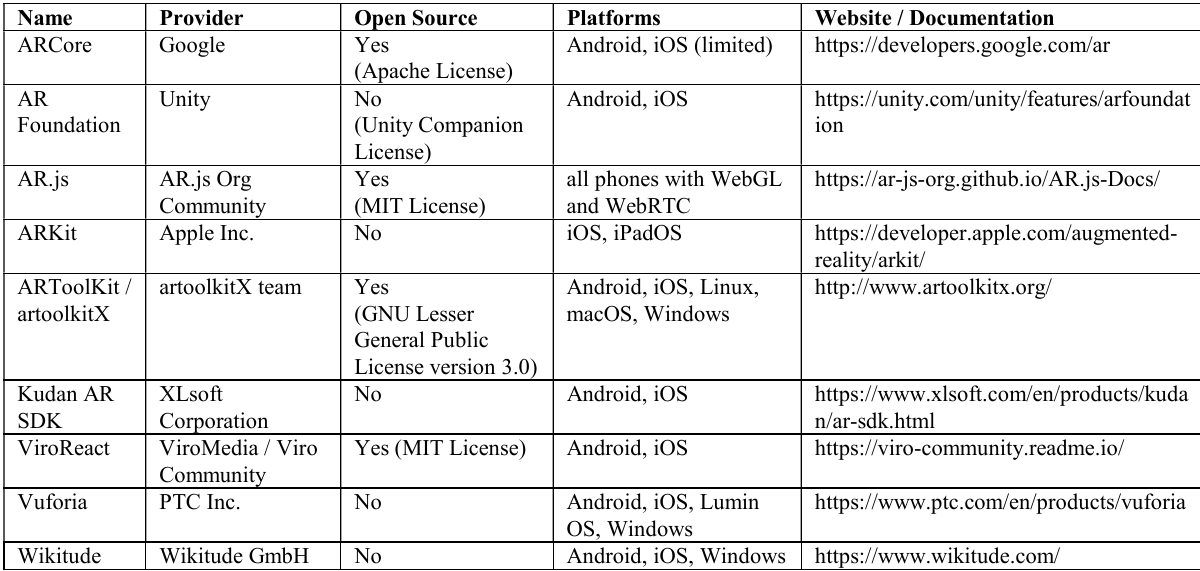
Table 1. A selection of currently available AR frameworks / SDKs /